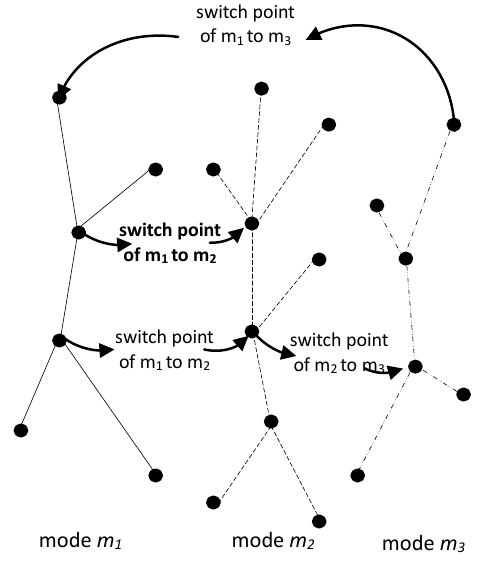
Figure 1. Model of multimodal route network